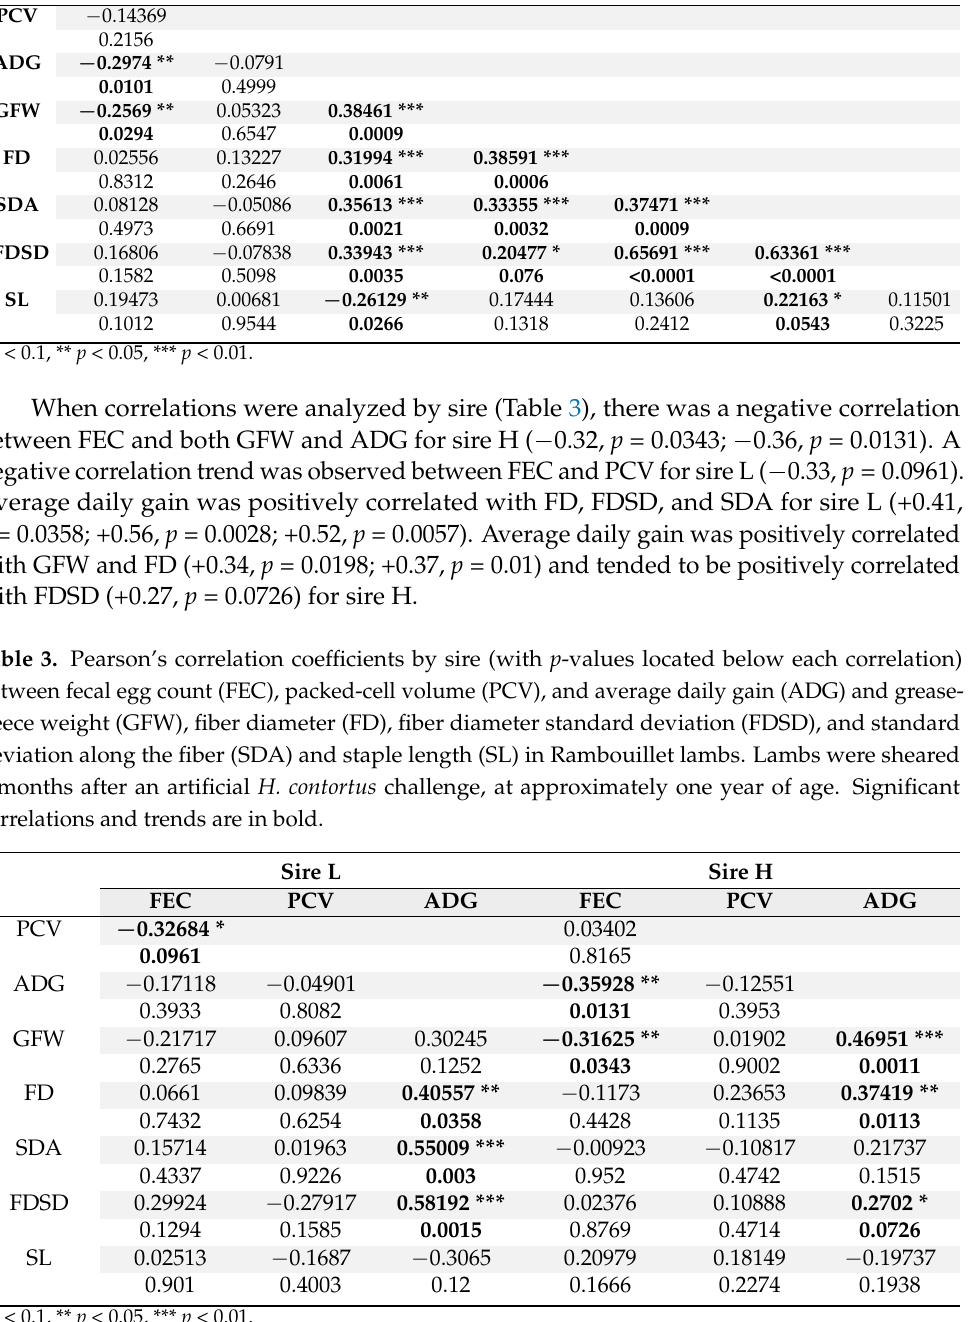
Table 2. Pearson’s correlation coefficients (with p -values located below each correlation) between fecal egg count (FEC), packed-cell volume (PCV), and average daily gain (ADG) and grease-fleece weight (GFW), fiber diameter (FD), standard deviation along the fiber (SDA), fiber diameter standard deviation (FDSD), and staple length (SL) in Rambouillet lambs. Lambs were sheared 4 months after an artificial H. contortus challenge, at approximately one year of age. Significant correlations and trends are bolded. FEC PCV ADG GFW FD SDA